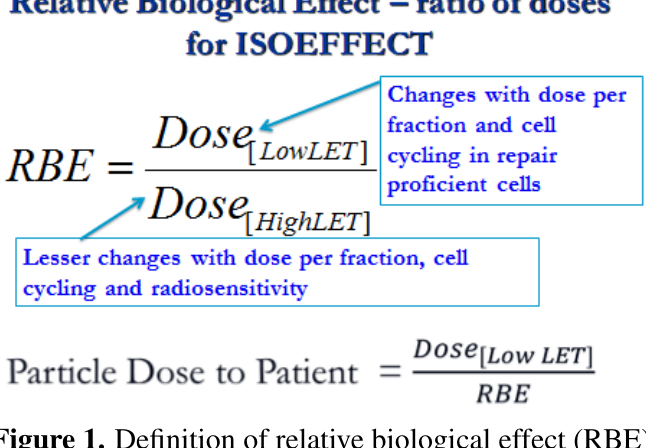
Figure 1. Definition of relative biological effect